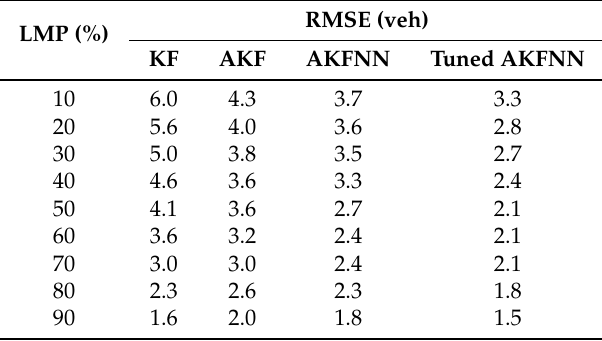
Table 6. RMSE values for the KF, the AKF, the AKFNN, and the tuned AKFNN models. RMSE (veh) LMP (%) KF AKF AKFNN Tuned